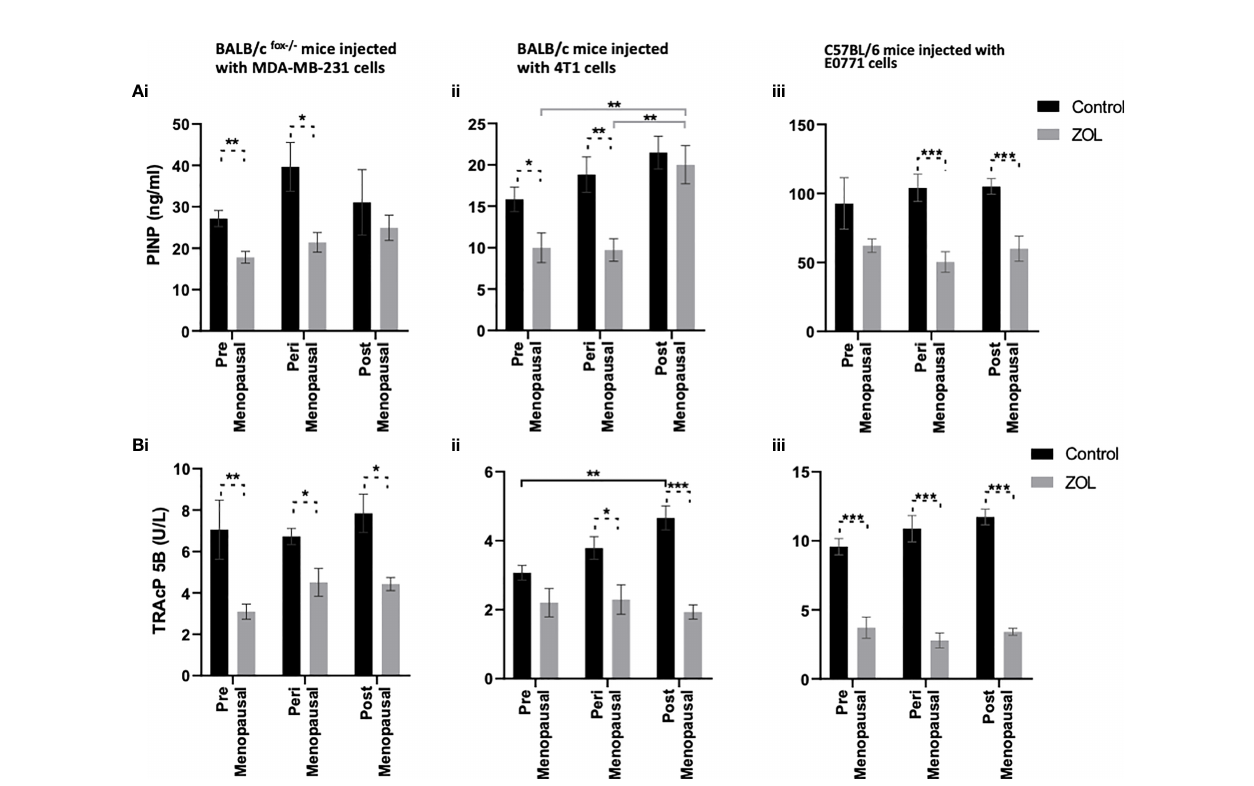
FIGURE 7 | Effects of zoledronic acid on bone cell activity in mice supplemented with pre- peri- and post- menopausal concentration of oestradiol following tumour cell injection. Histograms show osteoblast activity as measured by P1NP ELISA (A) and osteoclast activity as measured by TRAcP5 b activity (B) from the serum of BALB/c fox/- mice (i), BALB/c (ii) and C57BL/6 (iii) mice injected with MDA-MB-231, 4T1 and E0771 cells respectively (n=10/group). Cell lines were disseminated directly into the blood stream of the mouse via intra-cardiac injection 3, 6 and 7-days after induction of pre- peri or post-menopausal concentrations of oestradiol in BALB/c nude, BALB/c and C57BL/6 respectively and 3 days after fi rst injection of zoledronic acid. Zoledronic acid was administered weekly at a dose of 100ug/kg and all mice received daily injection of goserelin (40ug/kg). All data are shown as mean +/- SD and statistical signi fi cance are represented as *P < 0.05, **P < 0.01 and ***P <